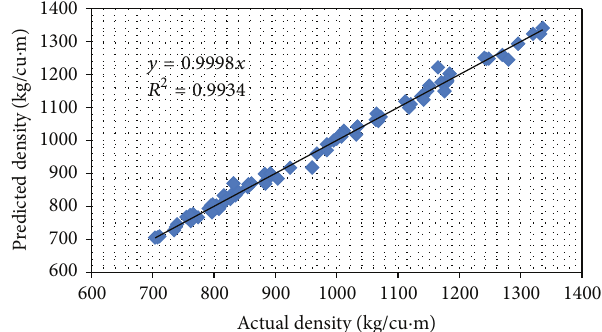
Figure 8: Performance of the compressive strength by nonlinear regression model.